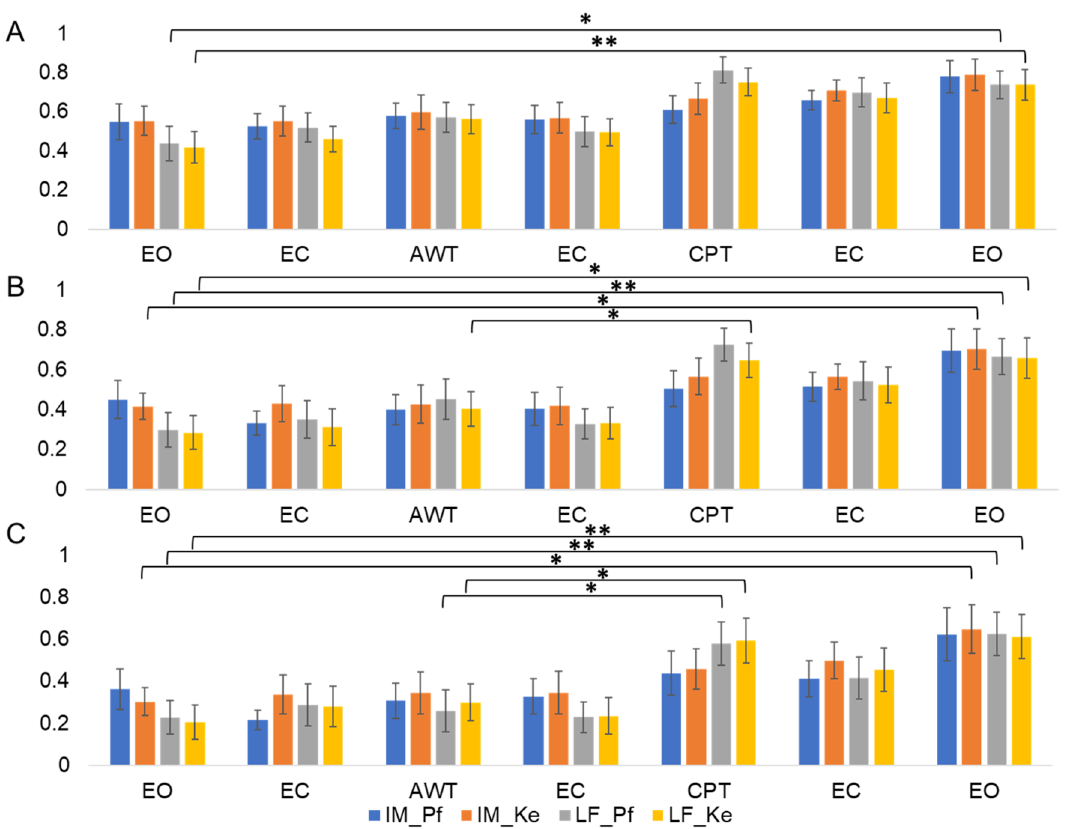
Figure 17. Bar graphs of phase desynchronization for LF and IM frequency band definitions based on Pfurtscheller (Pf) and Keller (Ke), and different thresholds in the main group ( N = 13). ( A ) Ratio R φ>π/ 4 shows a general increasing trend of phase desynchronization and a significant increase from stage 1 to 7 for LF_Pf and LF_Ke. ( B ) Ratio R φ> 3 π/ 8 showing general increasing trend throughout measurement and significant increase from stage 1 to 7 for IM_Ke, LF_Pf and LF_Ke exhibit significantly higher phase desynchronization during CPT. ( C ) Ratio R φ>π/ 2 showing general increasing trend and significant increase from stage 1 to 7 for IM_Ke, LF_Pf and LF_Ke. There is a significant difference between AWT and CPT for LF_PF and LF_Ke. Asterisks indicate (*) p -value < .05 or (**) p -value significant after Bonferroni correction at p < .0125. Error bars show standard error